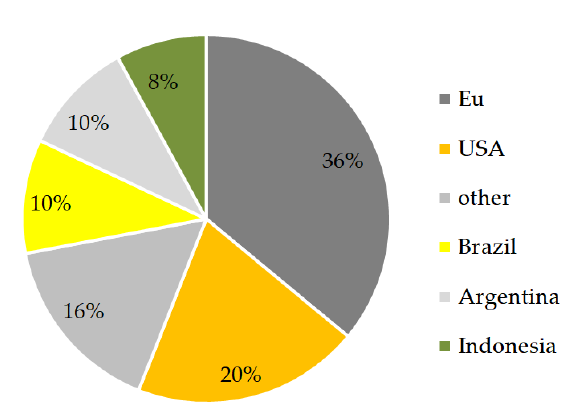
Figure 2. Leading producing countries of biodiesel fuel.